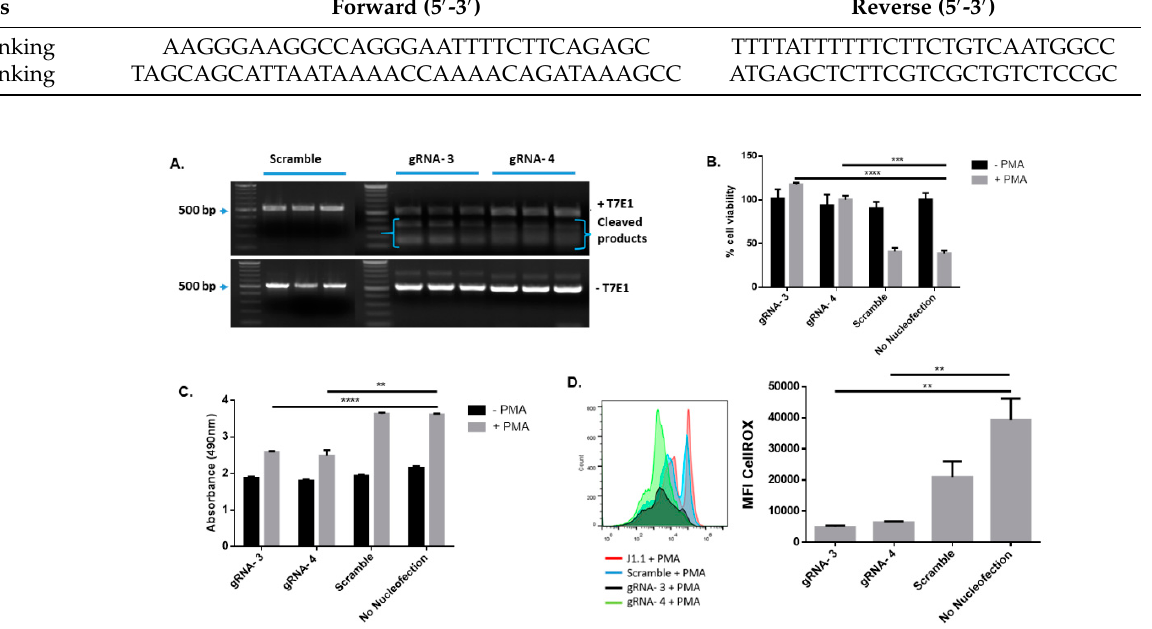
Figure 4. Mismatch mutagenesis, cellular cytotoxicity, and ROS production in J1.1 cells treated with gRNA-3 or gRNA-4 RNP. ( A ) The mismatch mutagenesis was assessed by the T7E1 assay. The T7E1-cleaved HIV DNA fragments in gRNA-3 or gRNA-4 RNP-treated cells were analyzed by standard PCR. ( B ) Cellular viability of gRNA RNP-treated and untreated J1.1 cells was measured by the MTT assay. *** p < 0.001, **** p < 0.0001. ( C ) LDH release from the treated and untreated cells was measured using the LDH release assay. ** p < 0.01, **** p < 0.0001. ( D ) CellROX assay was performed to assess ROS level in gRNA-3 or gRNA-4 RNP-treated cells in the absence or presence of PMA stimulation for 24 h. Representative histogram and the summary data of CellROX MFI are shown. ** p < 0.01.